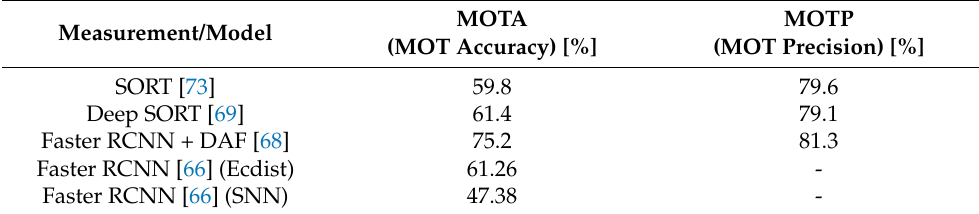
Table 5. The results (accuaracy, precision (%)) of human segmentation on the MOTChallenge dataset. SNN is a human tracking evaluation based on the Siamese Neural Network. Ecdist is a human tracking evaluation based on the simple minimum Euclidean distance.